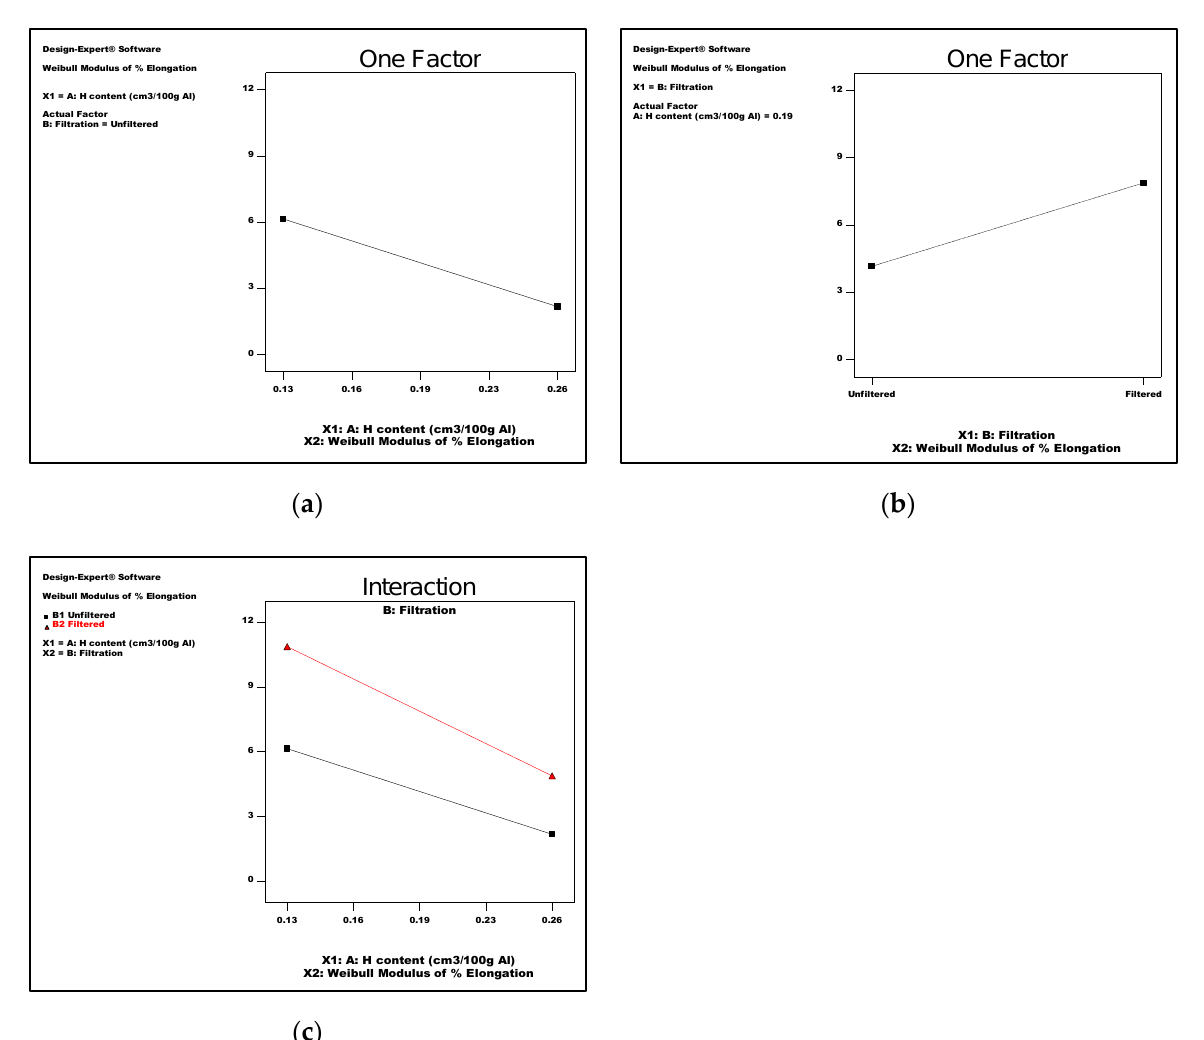
Figure 5. Effect of ( a ) hydrogen level, ( b ) filtration, ( c ) the interaction between hydrogen level and filtration on m ELONG .